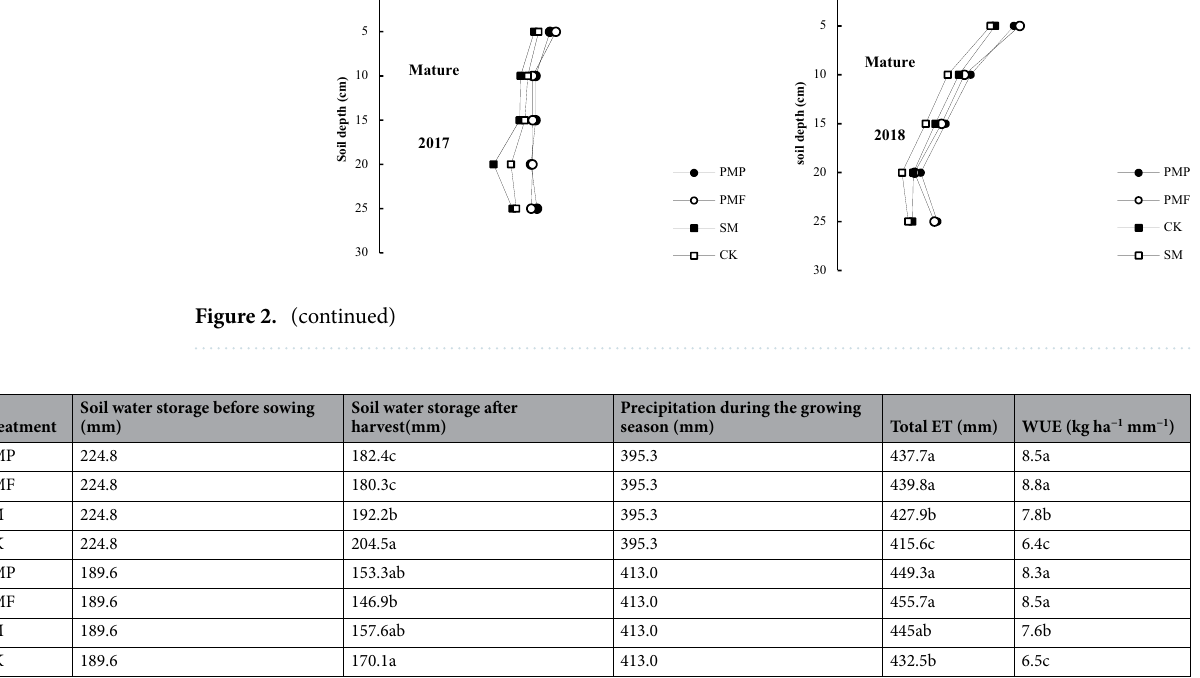
Table 2. Soil water consumption and water use efficiency under different cultivation practices in Hesheng County of Gansu Province, China, in 2017 and 2018. Different letters indicate significant differences (P < 0.05) between treatments for soil water storage after harvest, total ET, and